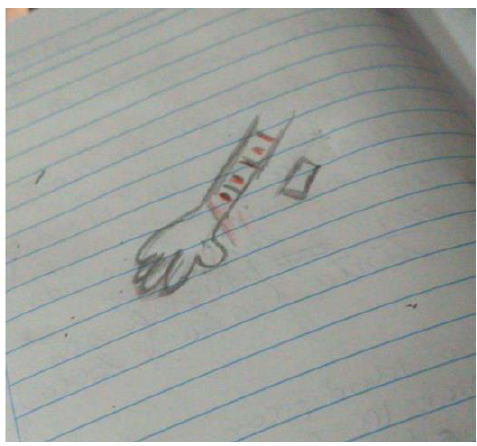
Figure 4. Drawing of self-harm as a manifestation of depression by a young adult.